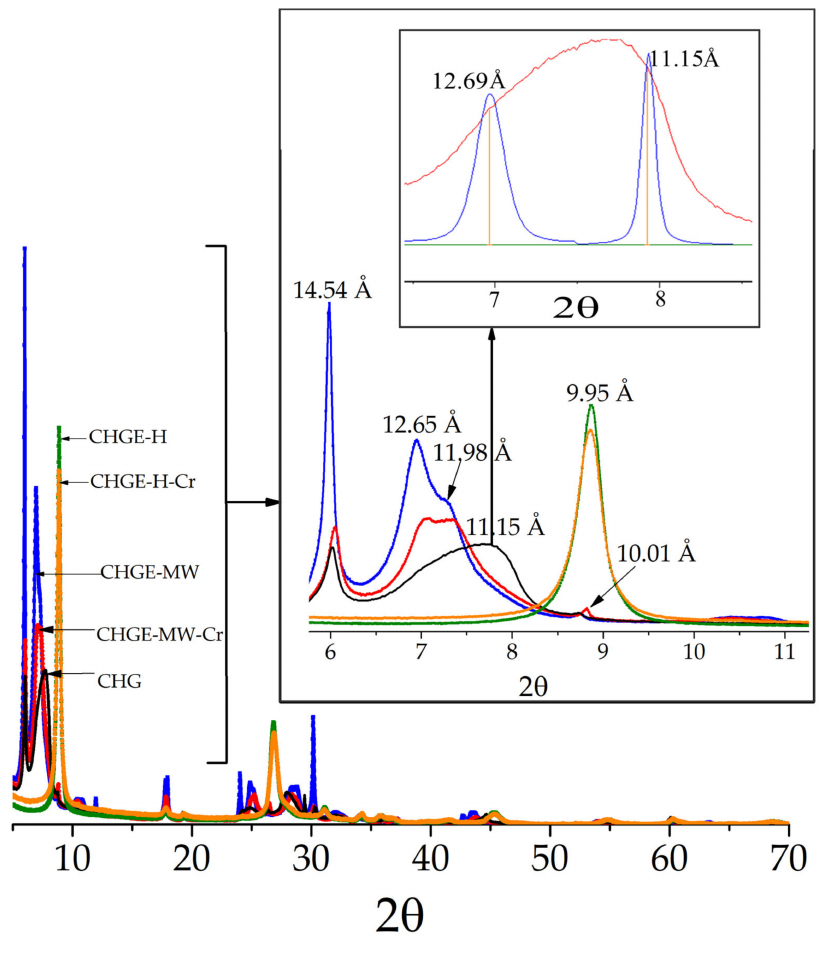
Figure 2. XRD patterns of the